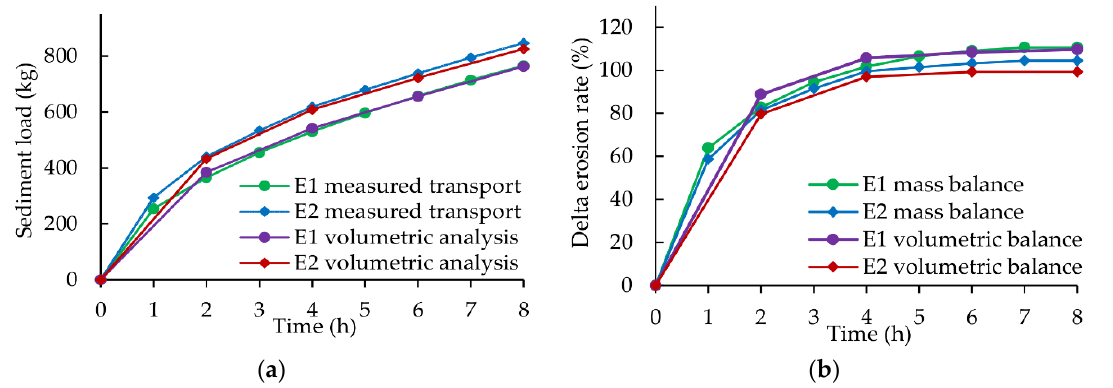
Figure 8. Measured transport rates and results from volumetric analysis, ( a ) cumulative sediment load; ( b ) delta erosion rate.